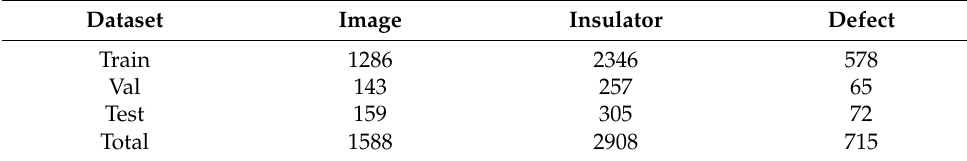
Table 1. Data set Table 1. Data set division.